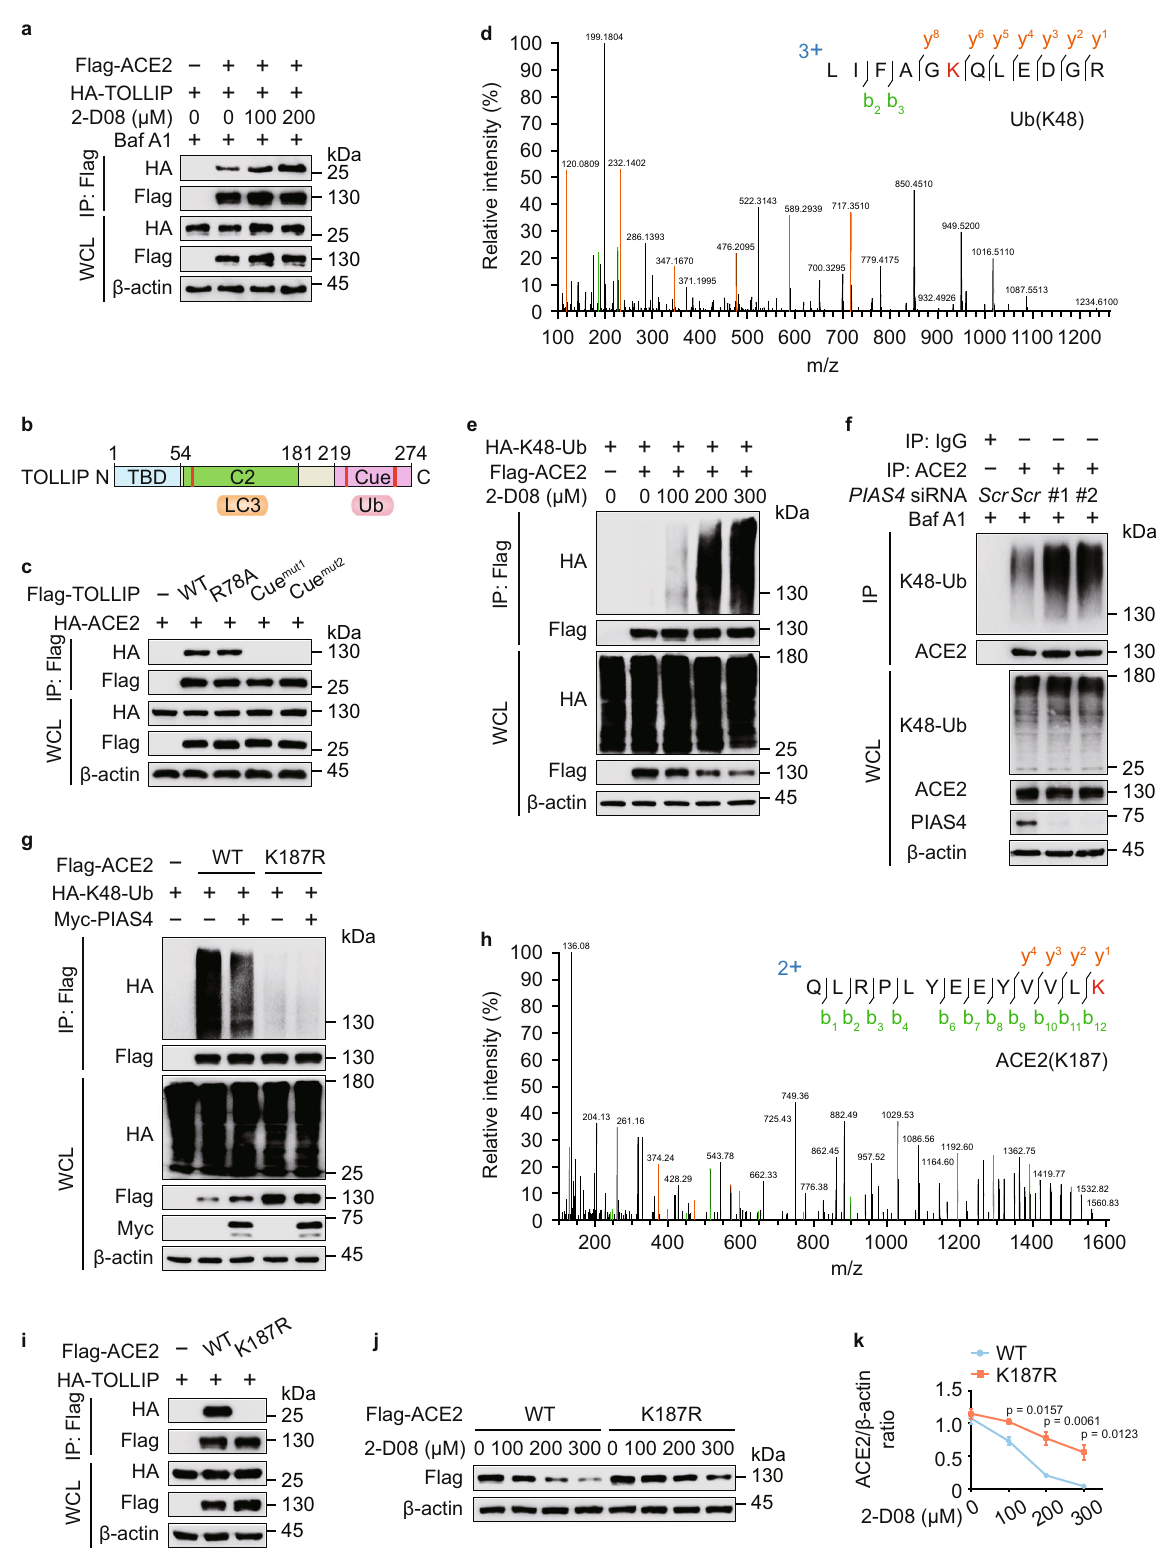
cloned into the FG-EH-DEST (provided by Dr. Xiaofeng Qin ’ s labora- tory) for retroviral expression. Plasmids encoding K187R, K234R, K465R, K481R, and K534R mutants of ACE2 were generated using pcDNA3.1-ACE2-Flag as a template by site-directed mutagenesis using theMutExpress ®